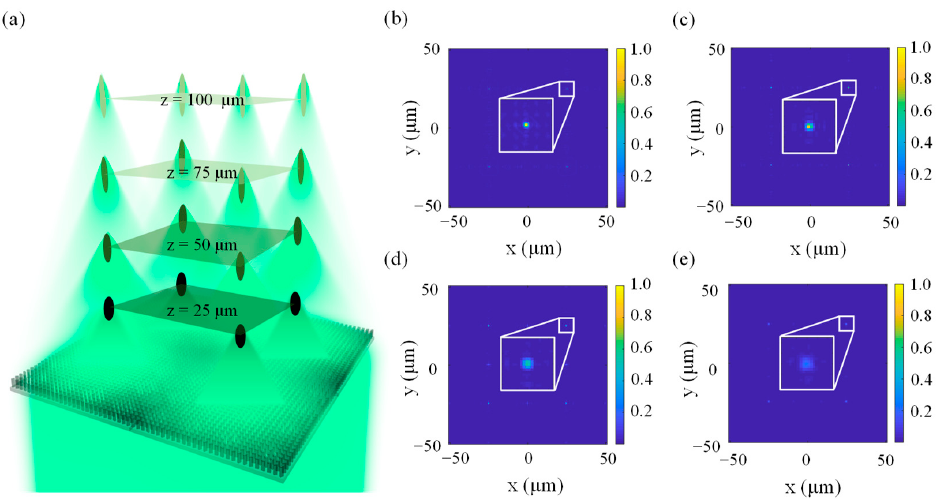
Figure 7. A 3D-arrayed multifocal metalens. ( a ) Schematic diagram of a spatial-array multifocal metalens. Distributions of light intensity in the z = ( b ) 25 µ m, ( c ) 50 µ m, ( d ) 75 µ m, and ( e ) 100 µ m planes, respectively.